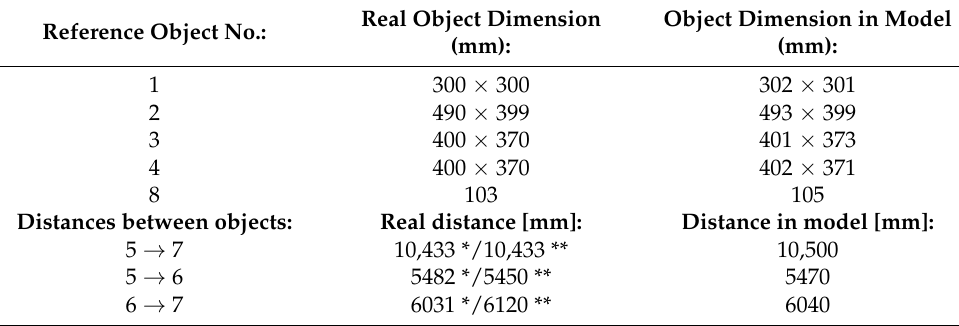
Table 3. Differences between reference objects dimensions (reality vs.